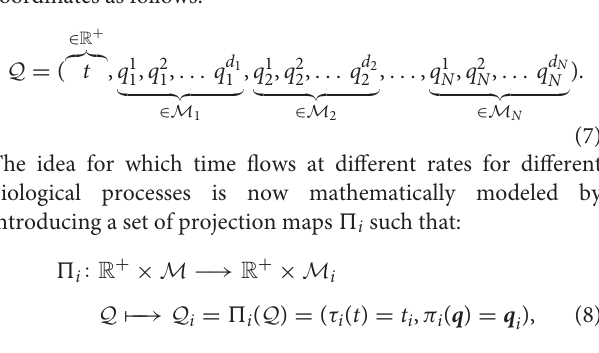
manifold given by the Cartesian product (the set of all ordered pairs) (see Tu,